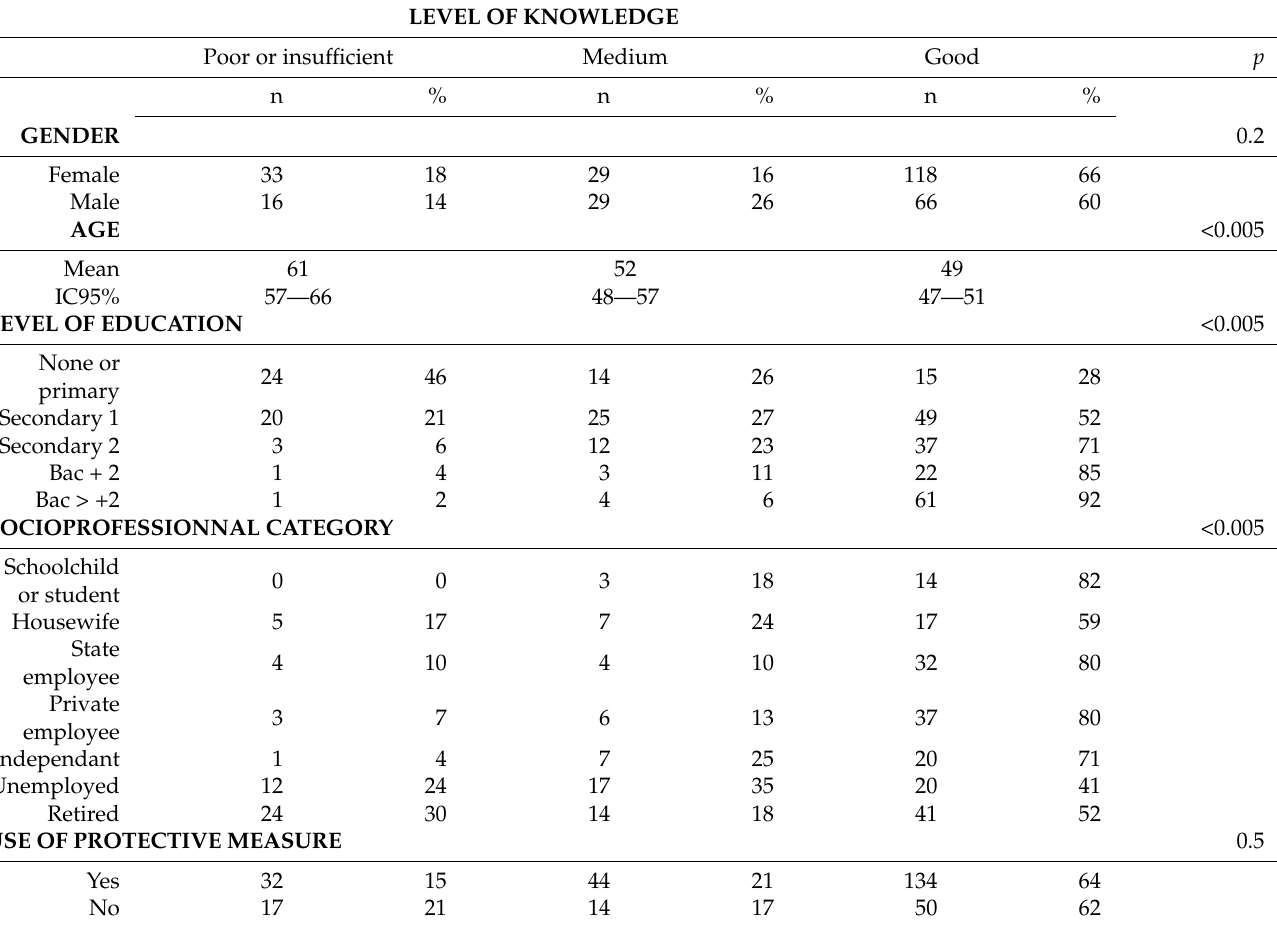
Table 1. Cross analysis between demographic characteristics or the experience of a dengue-like symptoms and the level of knowledge. LEVEL OF